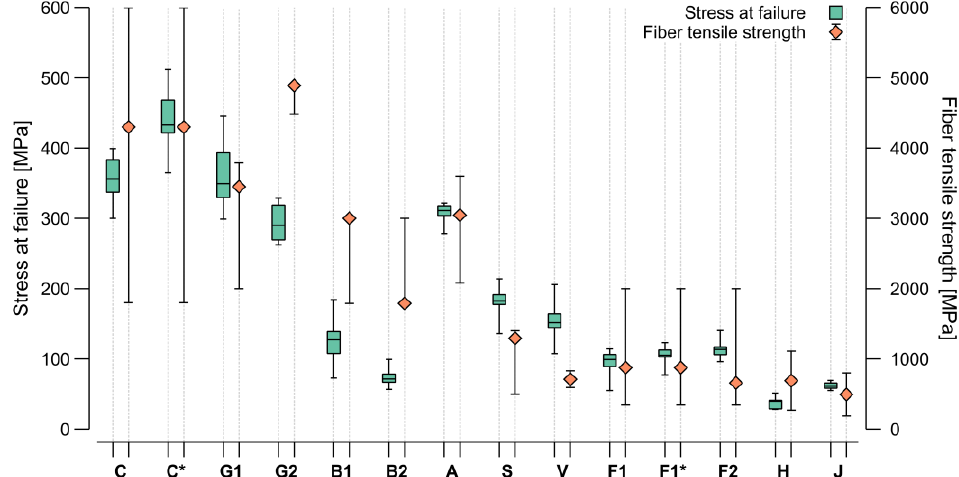
Figure 12. Comparison between the stress at failure (green) in the four-point bending tests and the fiber tensile strength (orange) of the selected product, with its placement in the range reported in the literature. For H and J, the average values were calculated from the literature. The whiskers for both data traces represent the min/max range. Scale factor between axis is 1:10. C — carbon, C* — carbon